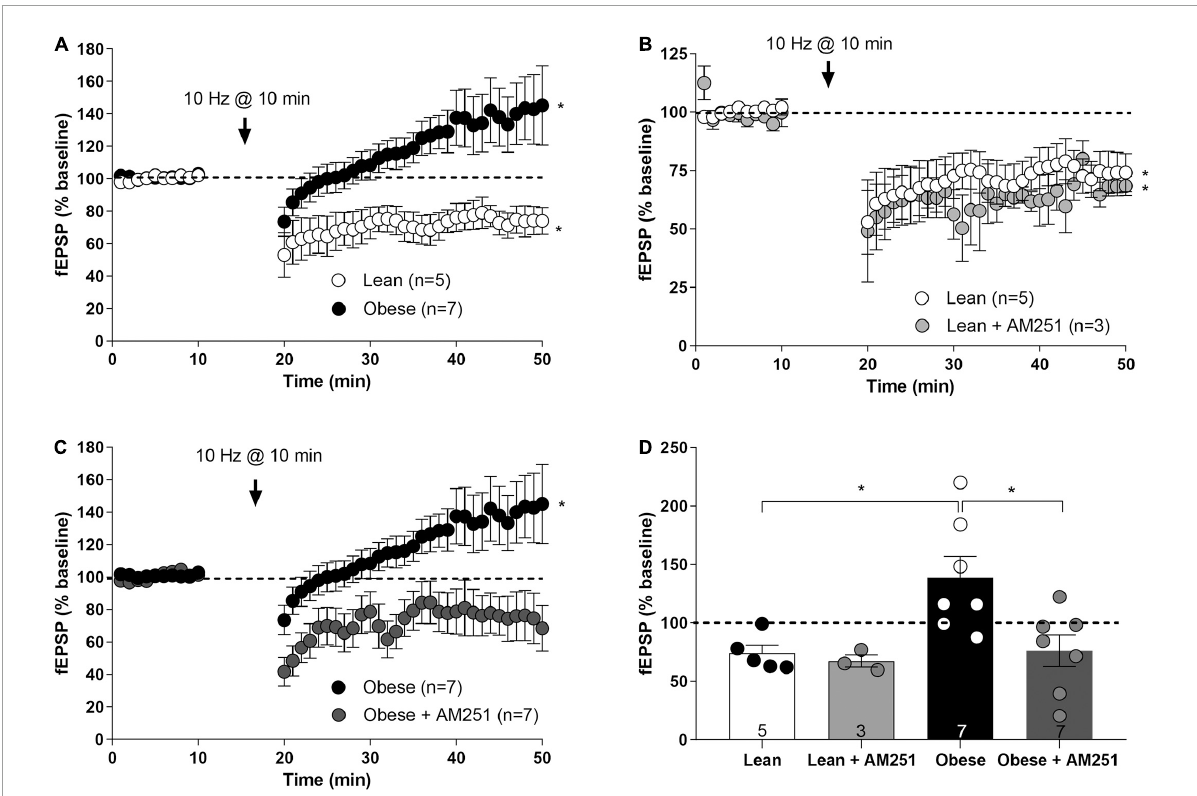
FIGURE8 Long-term synaptic plasticity at infralimbic mPCx synapses of the lean and obese Zucker rats. (A) Low frequency stimulation (LFS; 10 Hz for 10 min) at the time marked by the X -axis break triggers a depression of the fEPSPs (IL-eLTD) in lean rats (white circles; Student’s t -test, two tailed, * p < 0.05 versus baseline), but a potentiation of the fEPSPs (IL-eLTP) in obese Zucker rats (black circles; Student’s t -test, two tailed, * p < 0.05 versus baseline). (B) Bath perfusion with AM251 (4 µ M) in lean rats is ineffective at changing IL-eLTD (light gray circles; Student t -test; * P < 0.05 versus baseline). (C) The slight but significant LTP in obese Zucker rats (black circles) is suppressed by AM251 (4 µ M; dark gray circles; Student t -test; * P < 0.05 versus baseline). (D) Summary bar histogram of the experiments performed: lean, lean + AM251 (4 µ M), obese, obese + AM251 (4 µ M). Student t -test; * P < 0.05. Numbers in the bars are individual experiments. Data are expressed as mean ± SEM.